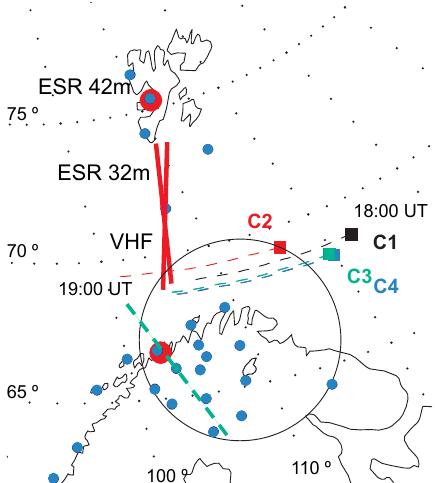
Fig. 3. Ground-based instrumentation used in this study. Red spots mark the EISCAT radar antenna locations in Tromsø (VHF, aacgm: 66.6 ◦ MLAT, 102.9 ◦ MLON) and on Svalbard (ESR 32m and 42m, aacgm: 75.2 ◦ MLAT, 111.9 ◦ MLON). The VHF and ESR 32m radar beams are drawn by red lines. Blue dots mark stations of the MIRACLE magnetometer network and the black circle the field of view of the KEV ASC (aacgm: 66.3 ◦ MLAT, 109.2 ◦ MLON) mapped to an altitude of 110km. Green dashed line centered at Kilpisj¨arvi (aacgm: 65.9 ◦ MLAT, 103.8 ◦ MLON) indicates the measurement range of the KIL MSP. The mapped Cluster trajec- tories (T96) between 18:00–19:00UT are shown by dashed lines using the same colour-coding for the spacecraft as in Fig.